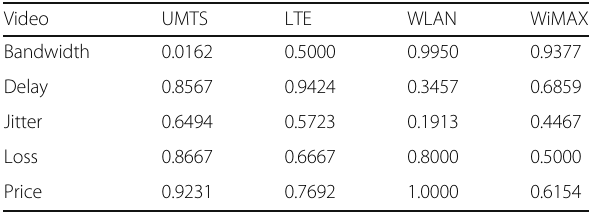
Table 19 Utility values of attributes for voice application in default parameter settings